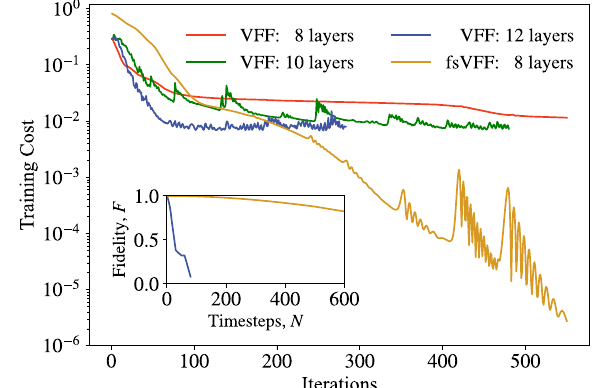
Fig. 6 fsVFF versus VFF training and fast forwarding. The 5-qubit ef fi cient layered ansatz and optimizer. For fsVFF the initial state is